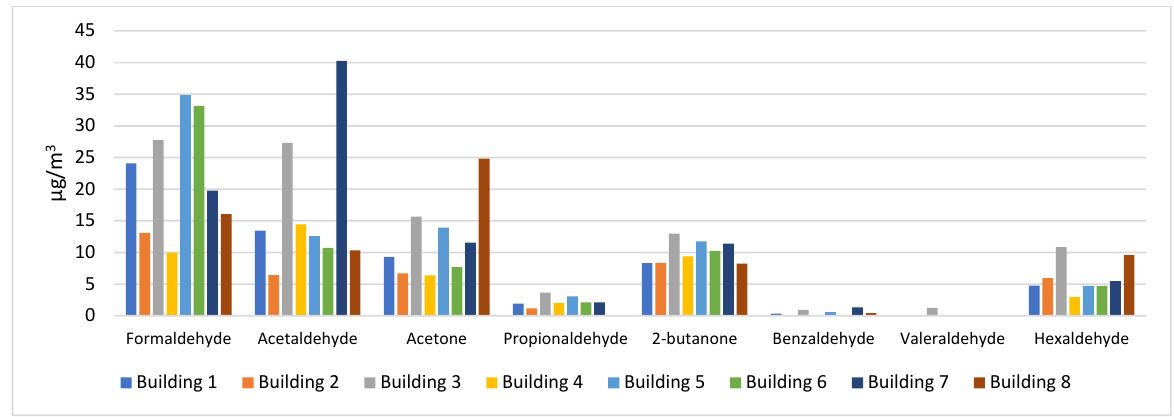
Figure 9. Indoor concentrations (μg m −3 ) of VOCs.